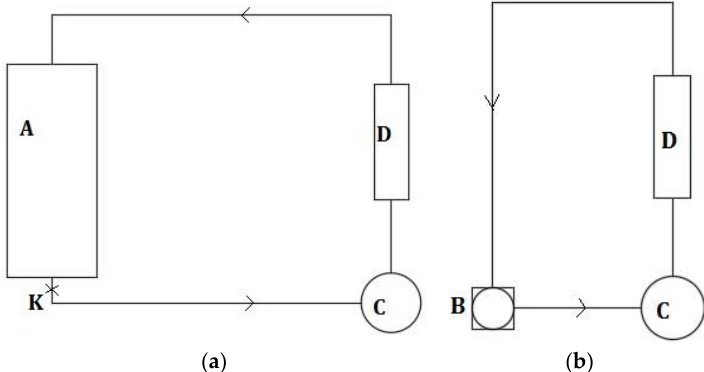
Figure 2. ( a ) scheme of the PCM heating process; A—Thermal fluid heater; C-Centrifugal pump;